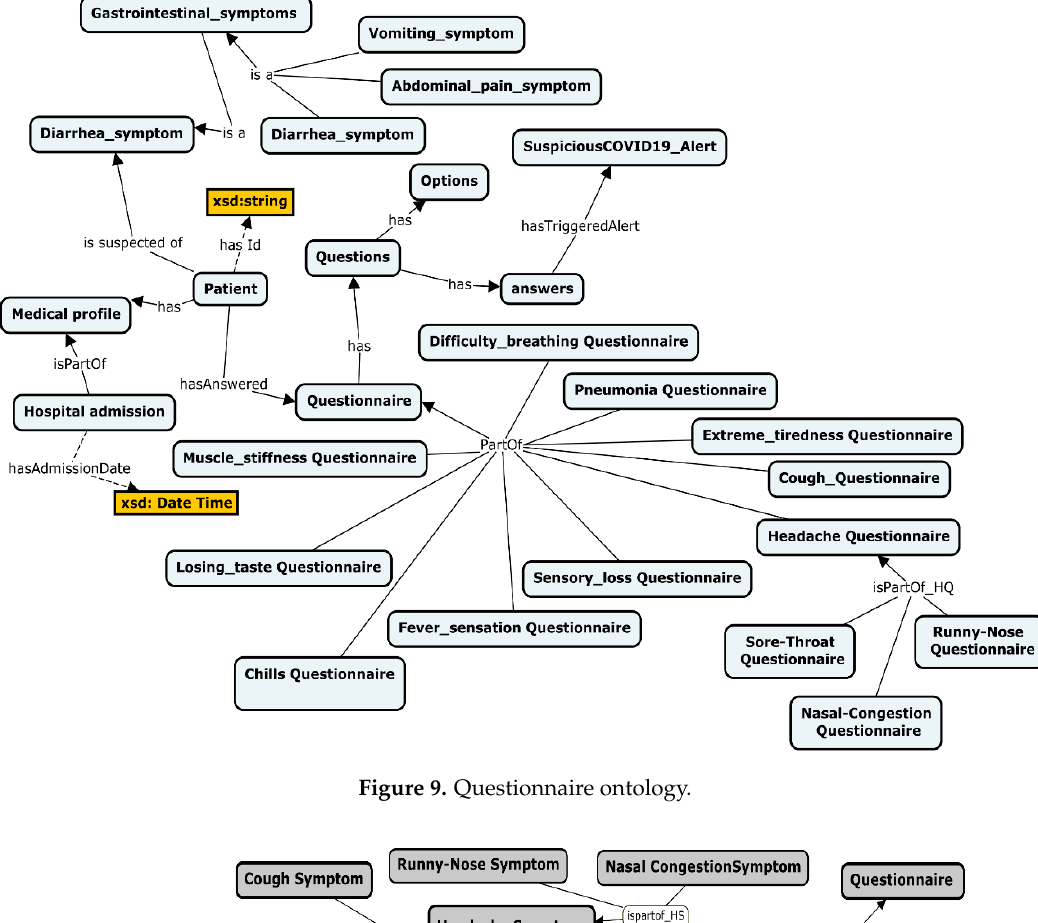
Figure 9. Questionnaire ontology.